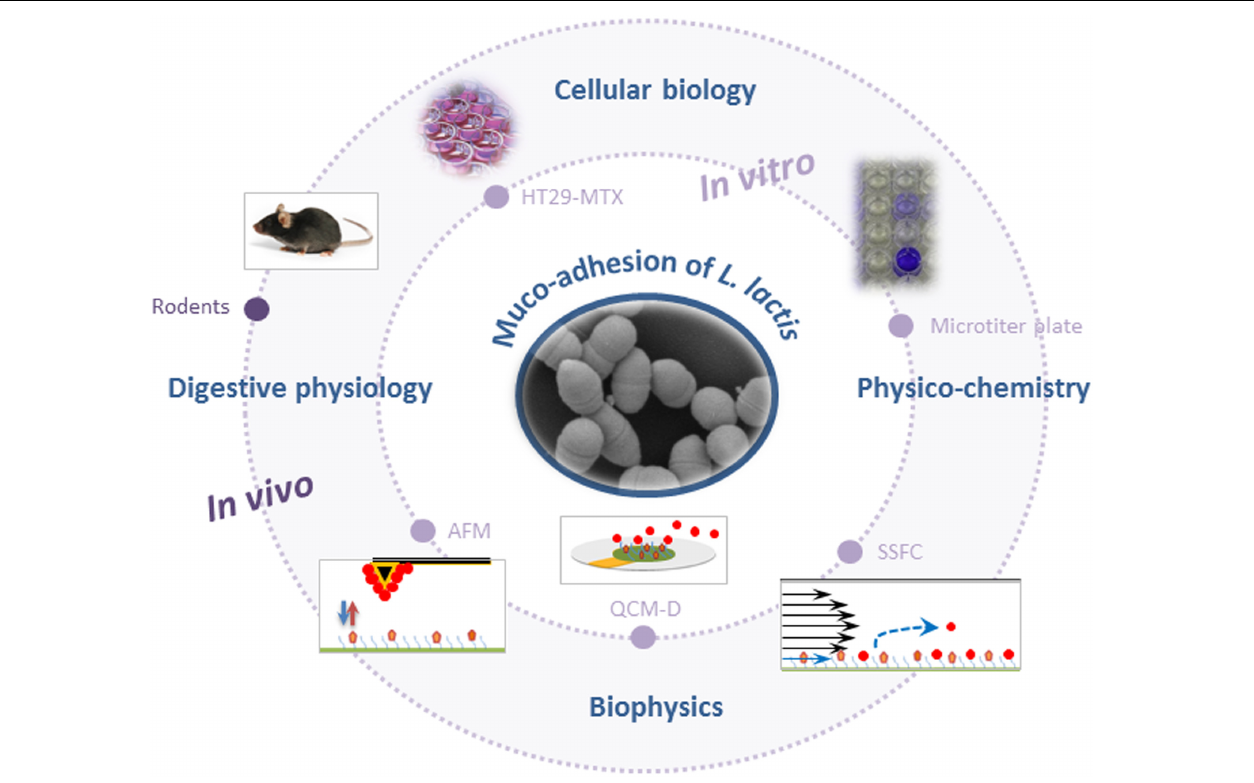
FIGURE 1 | Schematic representation of methods and tools used to probe muco-adhesion of Lactococcus lactis (AFM, atomic force microscopy; QCM-D, quartz crystal microbalance with dissipation monitoring; SSFC, shear stress flow chamber). For the sake of clarity, schemes are not to scale.